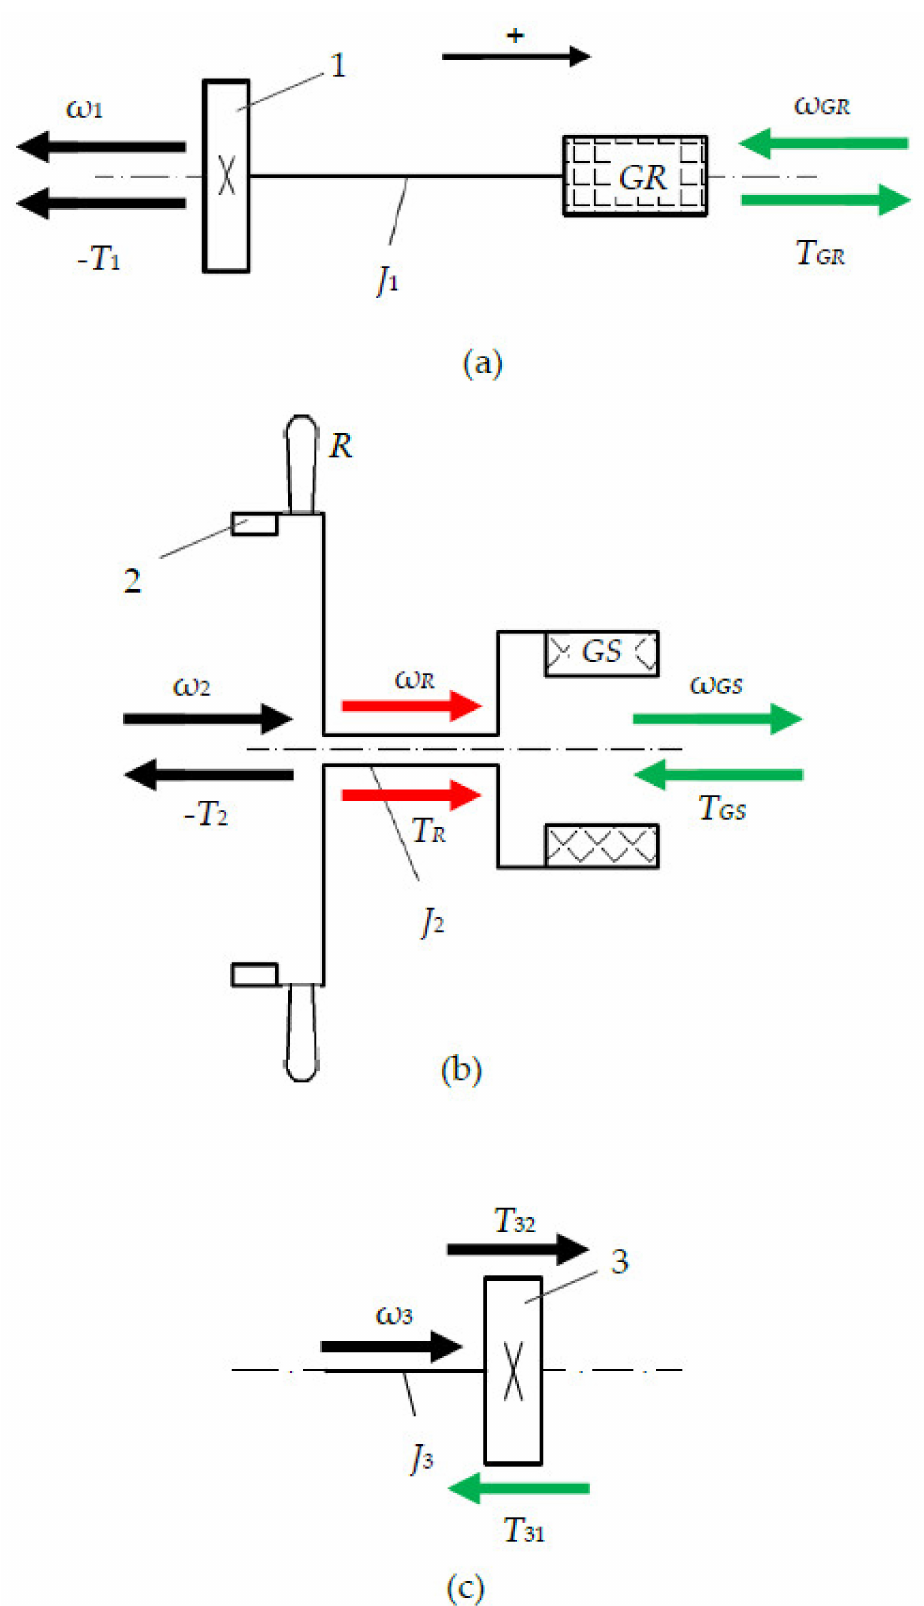
Figure 3. Dynamic scheme of: ( a ) body B1; ( b ) body B2; and ( c ) body